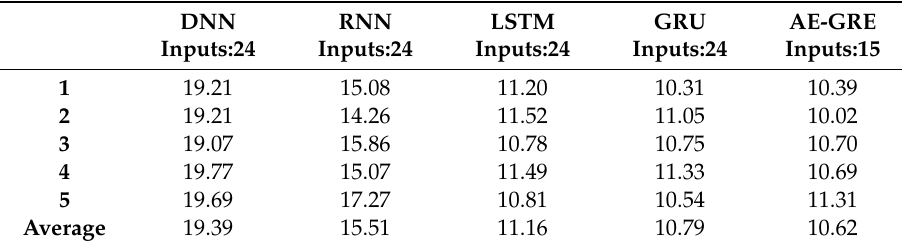
Table 7. RMSE results of different models under 5-fold cross-validation (Time steps = 10).